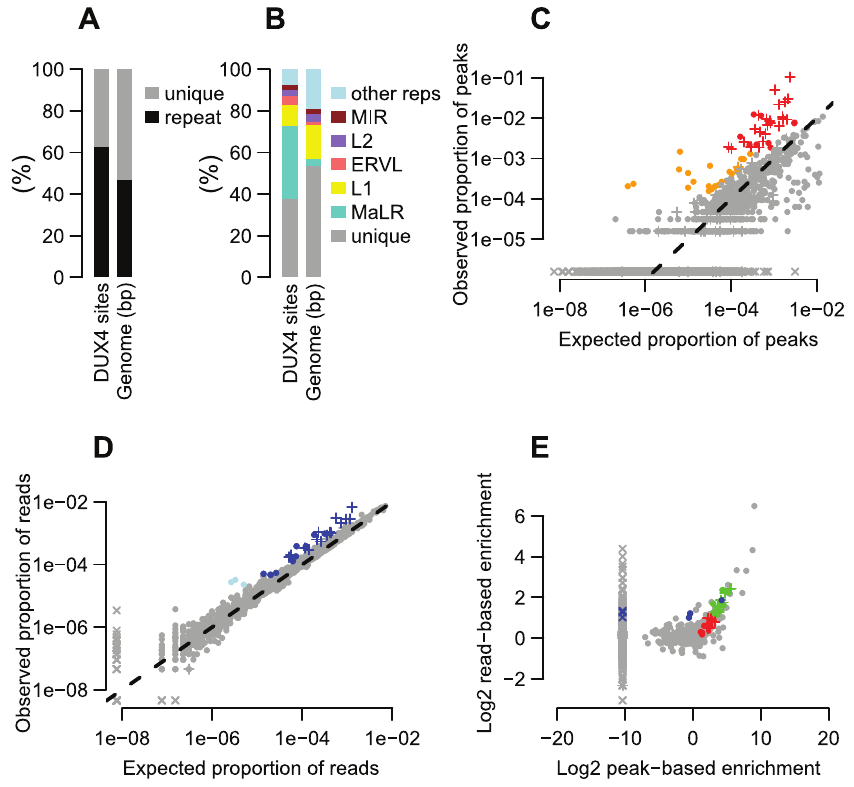
Figure 1. Many repeat types are enriched among DUX4 binding sites. (A) , 2/3 of DUX4 binding-sites are in repetitive elements, compared to , 45% of the human genome. (B) Comparing repeat family proportions among DUX4 binding-sites with genome-wide fractions shows , 10-fold MaLR enrichment. (C) A peak-based method of estimating repeat enrichment uses uniquely-mapped reads, so is blind to recently active repeats; however, it ignores background reads so provides a more sensitive enrichment measure than the read-based estimate (Figures 1D, 1E). 32 repeat types (red) are enriched $ 2-fold with $ 100 peaks (arbitrary thresholds) (Tables 1, S2 and S3); 21 (orange) are rarer in the genome (10–99 peaks) but enriched $ 4-fold. The log10-scaled x-axis shows the proportion of peaks expected to overlap each repeat type if DUX4 binding sites had uniform genomic distribution; the log10-scaled y-axis shows observed proportions. The dashed line represents no enrichment. In all panels, ‘‘ + ’’ symbols represent MaLR elements and ‘‘x’’ datapoints represent repeat types for which no peaks/reads were observed – these are given an arbitrary low (non- zero) value to ensure visibility on log-scaled plots. (D) The read-based enrichment estimation method examines highly similar repeats as well as uniquely-mappable sequences, but gives a ‘‘dampened’’ enrichment measure due to background reads in ChIP-seq samples (see Methods). 25 repeat types (dark blue) are enriched $ 2-fold, with $ 1000 reads (arbitrary thresholds); 3 (light blue) are rarer among ChIP-seq reads (100–999 reads) but enriched $ 4-fold. (E) The peak-based (x-axis) and read-based (y-axis) methods yield similar results. 19 repeat types (green datapoints, thresholds as in Figures 1A and B for red and dark blue points) were enriched in both analyses; 13 enriched only by the peak-based method (red), and 6 enriched only by the read-based method (blue). Additional repeats (gray datapoints, upper-right quadrant) appear enriched by both methods, but are rare in the genome so do not exceed our arbitrary peak/read thresholds.